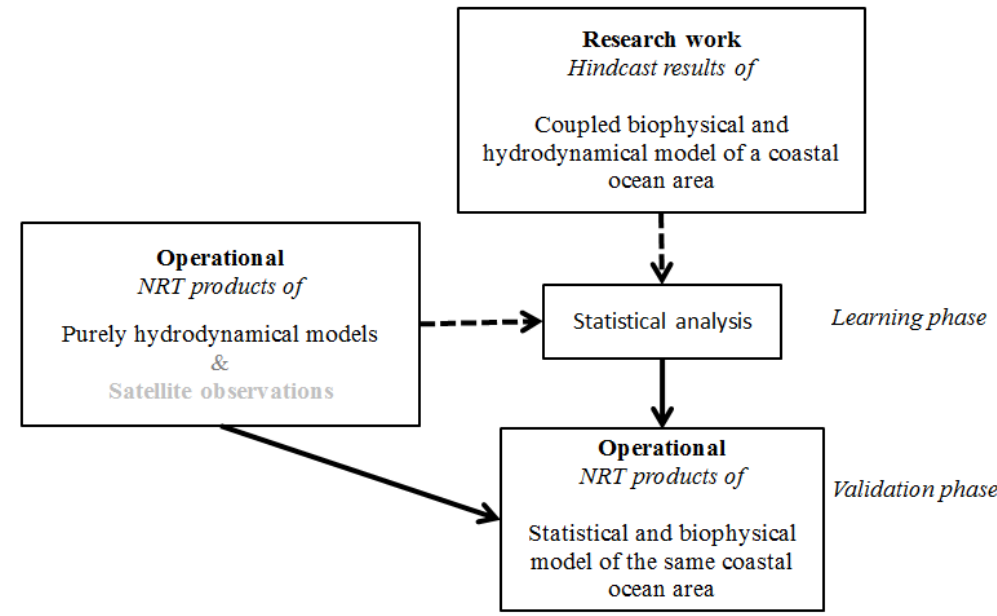
Figure 1. Schematic aim of the method. Plain arrows indicate data input of the operational statistical model. Dashed arrows indicate data input of the prior statistical analysis. Satellite measurements (in grey characters) can or can not be included in the